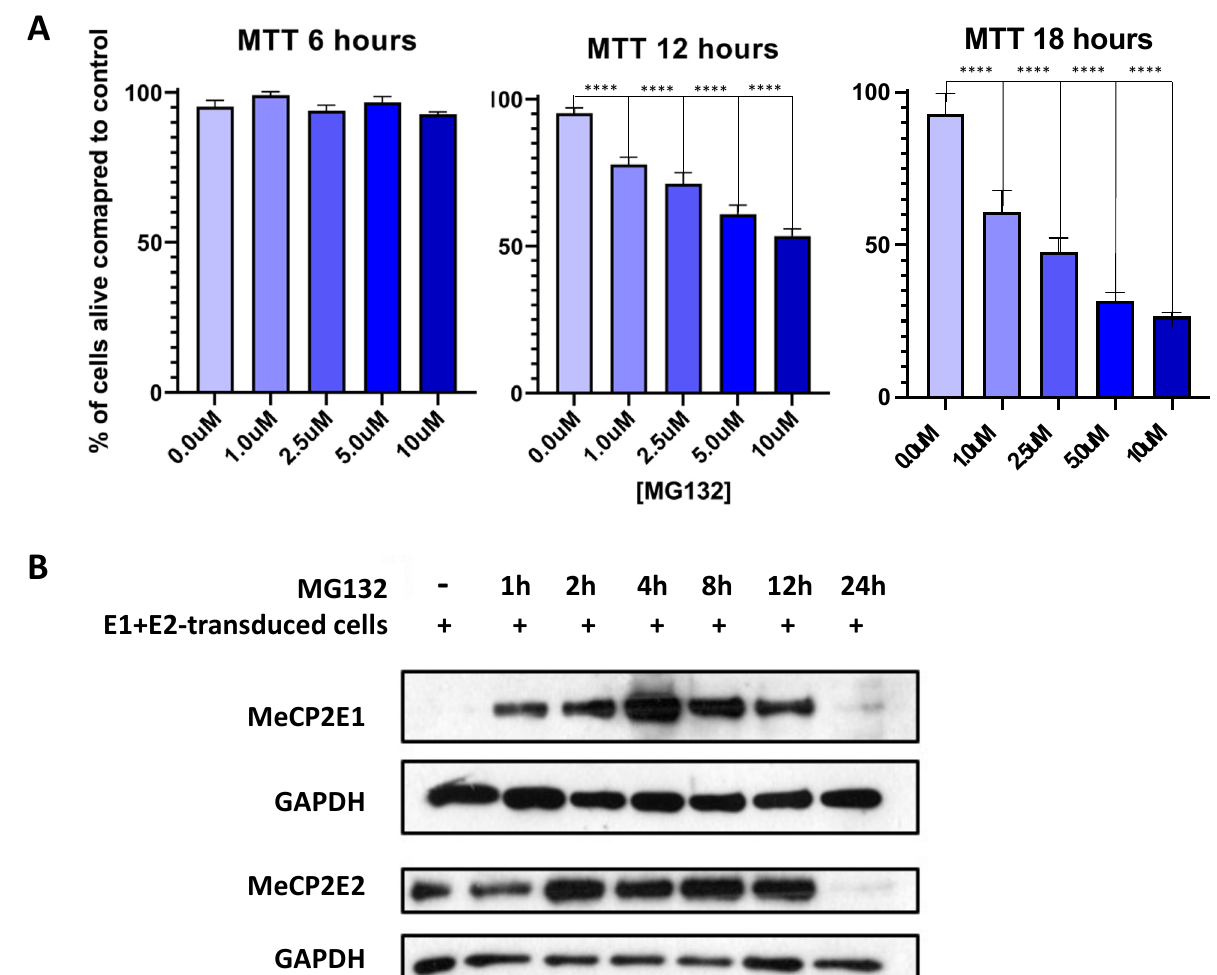
Figure 5. MTT cell survival assay and Western blot analysis of the E1 + E2-transduced cells treated with MG132. ( A ) Cell survival MTT assays were performed at 3 time points of 6 h, 12 h, and 18 h to determine the cell death/cell survivability with various incubation times and MG132 concentrations. All conditions were performed in n = 5, and data are reported as mean ± SEM with two-way ANOVA analysis, followed by Dunnett’s multiple comparisons test with significances of ****: p < 0.0001. ( B ) Western blot analysis of the E1 + E2-transduced Daoy cells treated with 2.5 µM of MG132, using anti-MeCP2E1 and anti-MeCP2E2 (h: hour). GAPDH loading control is shown as a housekeeping protein.